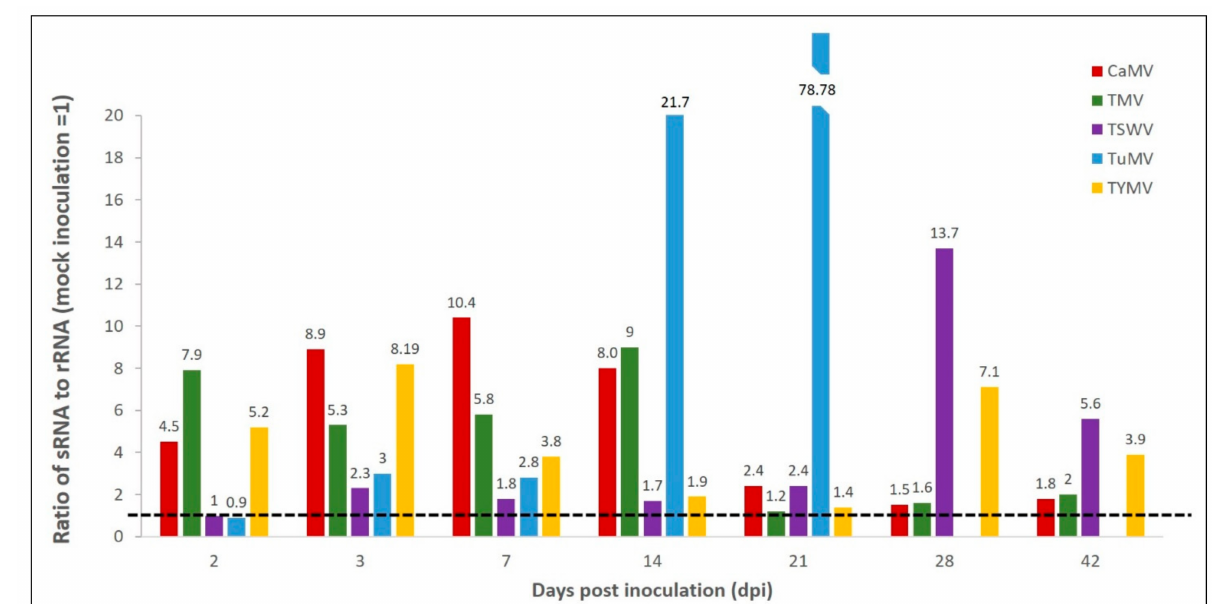
Figure 3. Ratio of sRNA to rRNA of cauliflower mosaic virus (CaMV)-, tobacco mosaic virus (TMV)-, tomato spotted wilt virus (TSWV)-, turnip mosaic virus (TuMV)- and, turnip yellow mosaic virus (TYMV)-inoculated total low molecular weight (LMW)-RNA compared to averaged mock-inoculation across the time course of 2 to 42 days post inoculation (dpi). Specific value given above each bar. Mock-inoculation is rescaled to 1.0. Black line at 1 corresponds to averaged